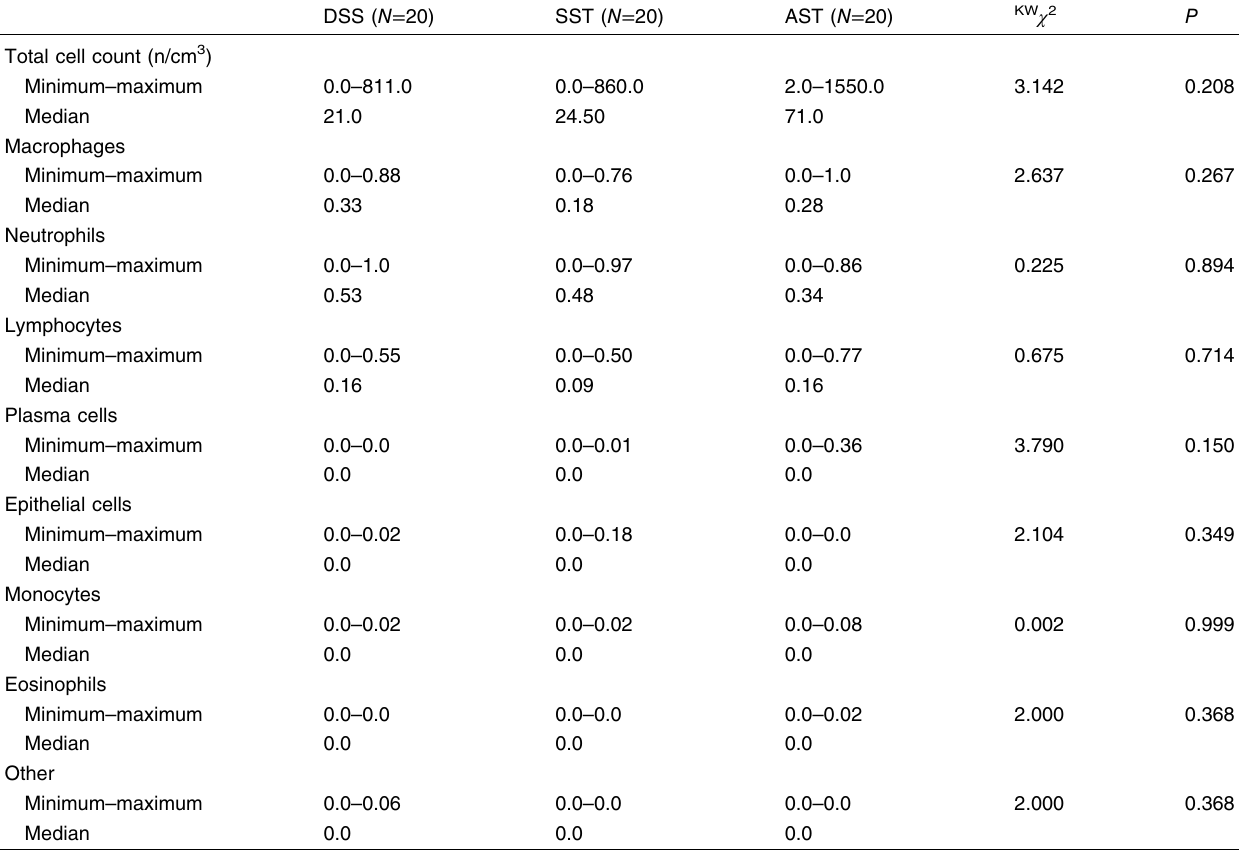
Table 4 Comparison among the three groups according to total and differential cell count of retrieved